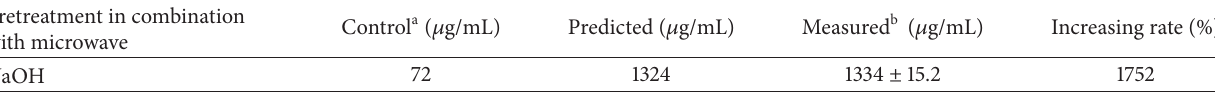
Table 4: Predicted and experimental reducing sugar obtained under optimum conditions.